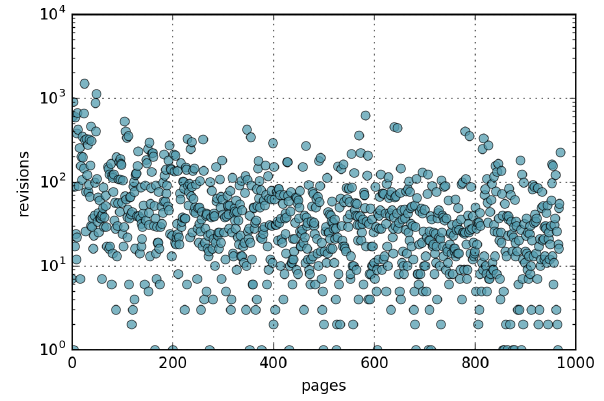
Figure 7. Revisions of the 1000 most popular Wikipedia pages in February 2016, sorted by view rank.